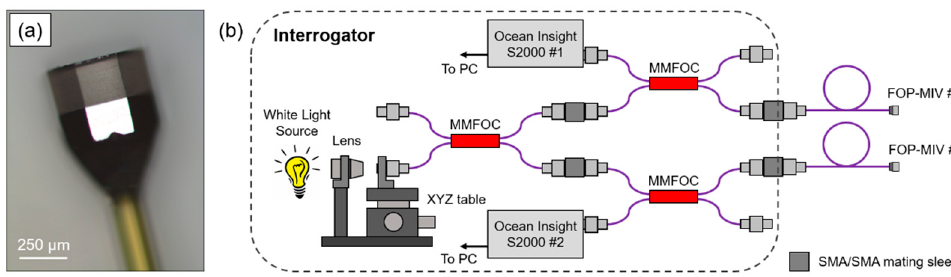
Figure 2. ( a ) Optical microscope image of the FOP-MIV sensor and ( b ) schematic of the in-house designed, bespoke interrogation system used to acquire changes in the FP cavity length of the FOP-MIV sensors.